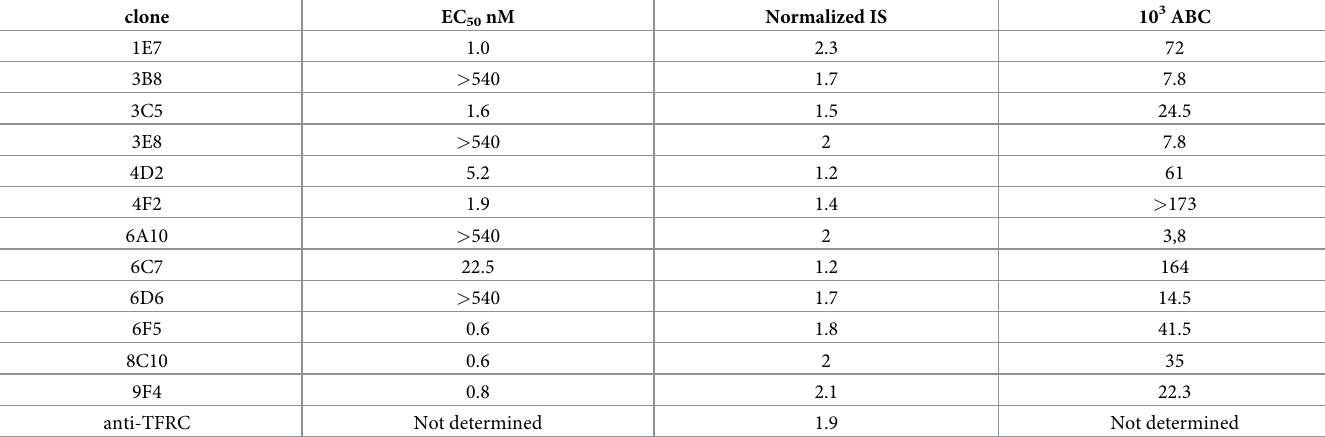
Table 1. hCMEC/D3 binding of 12 purified monoclonal antibodies, IS and ABC. clone